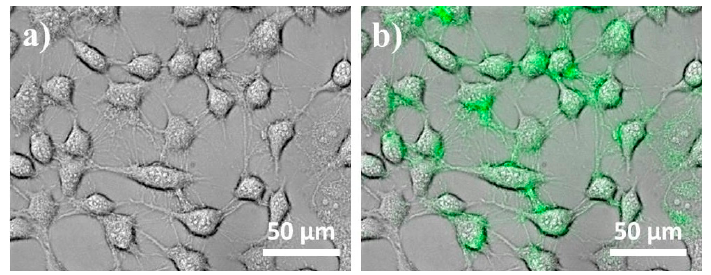
Figure 6. Phase contrast ( a ) and fluorescence ( b ) images of L-929 fibroblastic cells incubated with 10 μ g/mL of PEG–Ho 2 O 3 NPs.